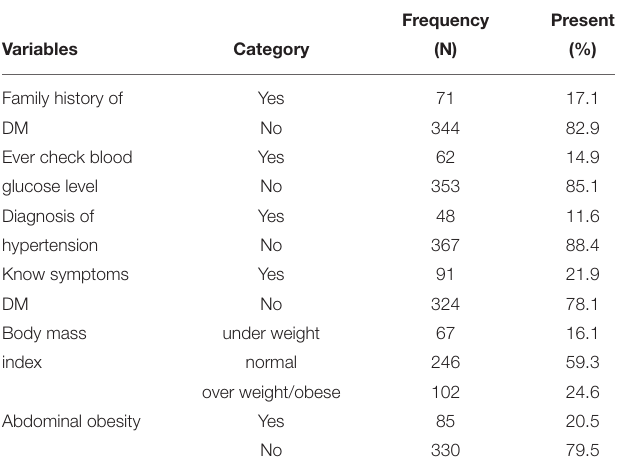
town (5%) (31), Dre Dawa (6.2%) (13), Gonder (6.34%) (14), Koladiba town north-west Ethiopia (2.3%) (15), Kuwait (6.9%) (32), and pooled estimate of the African population (5.37%)